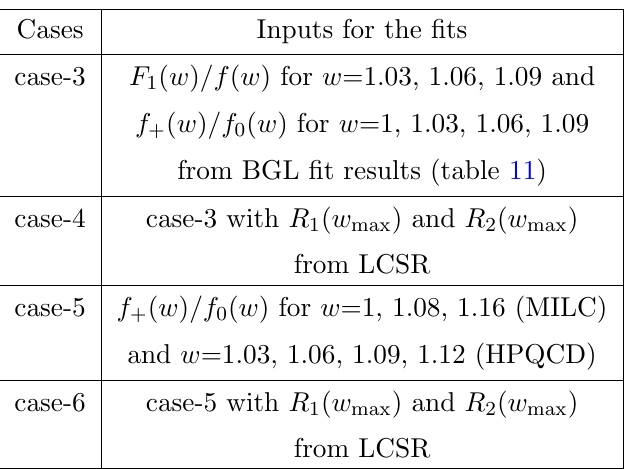
Table 12 . The decay widths and the masses of the B c resonances.